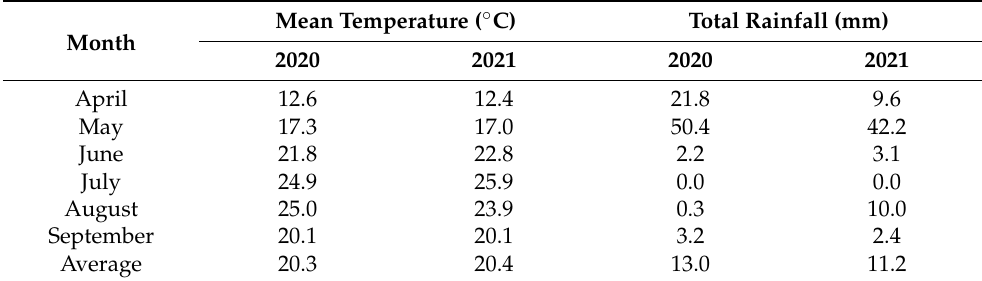
Table 3. Basic weather data during growing seasons. Mean Temperature ( ◦ C) Total Rainfall